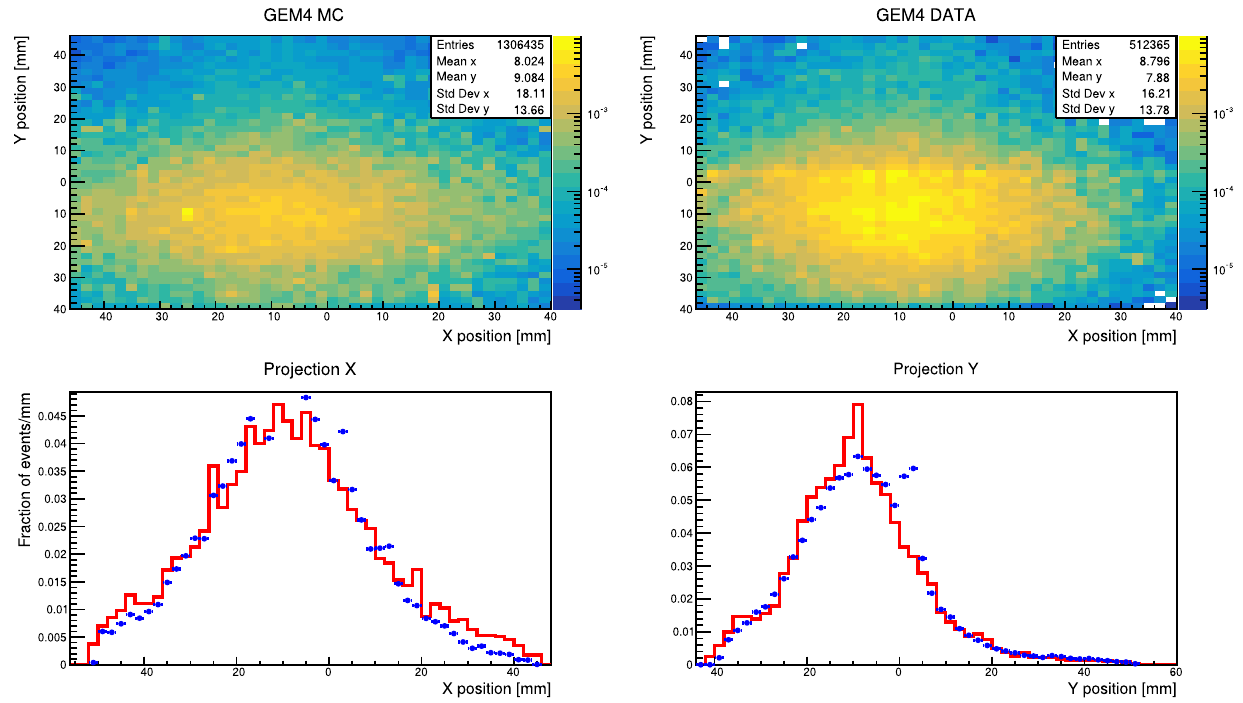
Fig. 5 Hit position recorded in last GEM before ECAL for MC simulated (Red curve) and data (Blue dots) e − Z → e − Z γ( → μ + μ − )